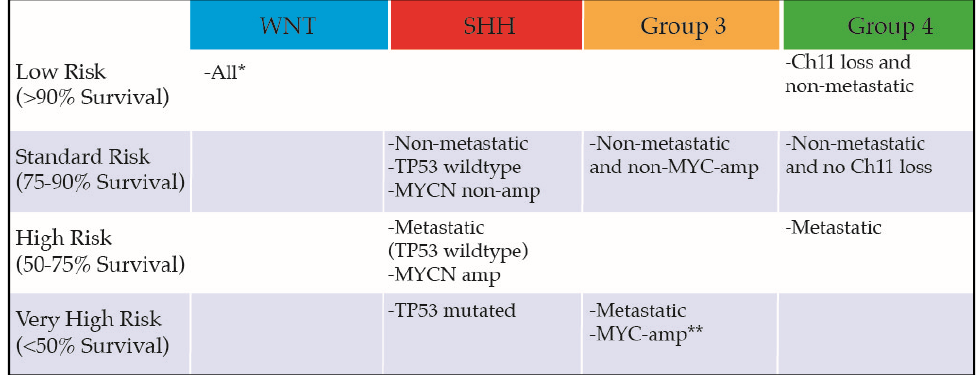
Figure 2. Current risk-stratification schema. * Metastatic WNT tumors are rare and have an unknown natural history. ** Nonmetastatic MYC-amplified tumors are likely very high risk and often recur in a metastatic pattern, but their upfront prognosis is not clear. Ch11, chromosome 11.